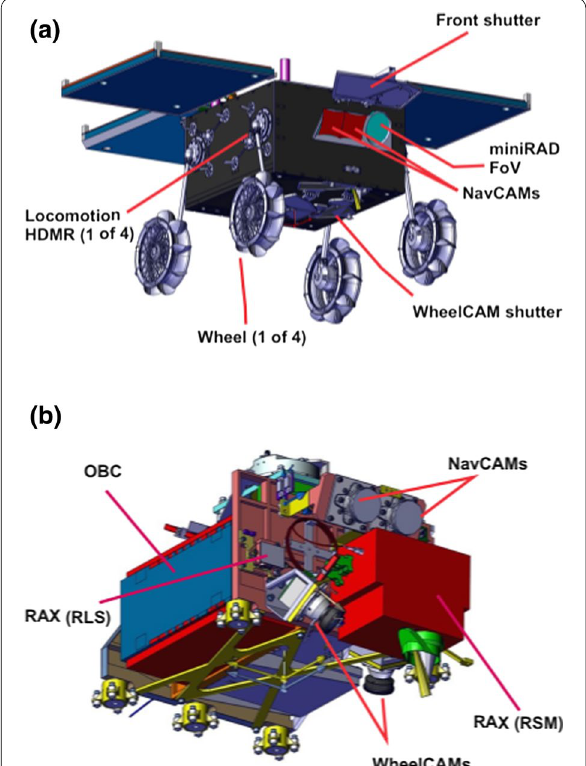
Fig. 1 Left: rover in fully deployed configurations with positions of MiniRad, rear WheelCam and NavCam stereo bench; right: internal compartment (service module—SEM) with position of instruments and on board computer (OBC). Courtesy from